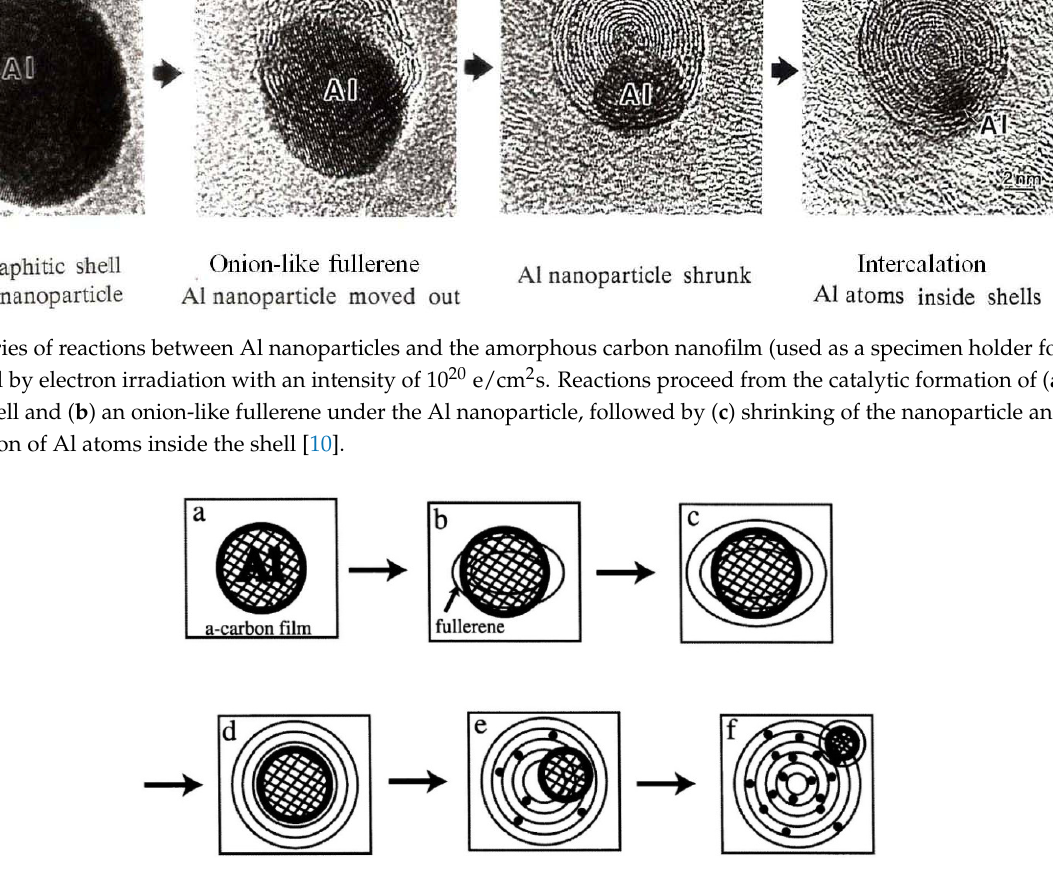
Figure 12. Schematic of a series of interaction behaviours between an Al nanoparticle and an amorphous carbon film under electron irradiation ( a :initial). The following steps occurred: a nucleus of the giant onion-like fullerene was first induced under the Al particles ( b ). Al nanoparticles were encapsulated in the giant onion-like fullerene ( c , d ). Al nanoparticles moved outside of the giant onion-like fullerene ( e ), which also induced a new giant onion-like fullerene ( f ). Finally, intercalation progressed as Al atoms migrated inside the giant onion-like fullerene shells ( e , f )